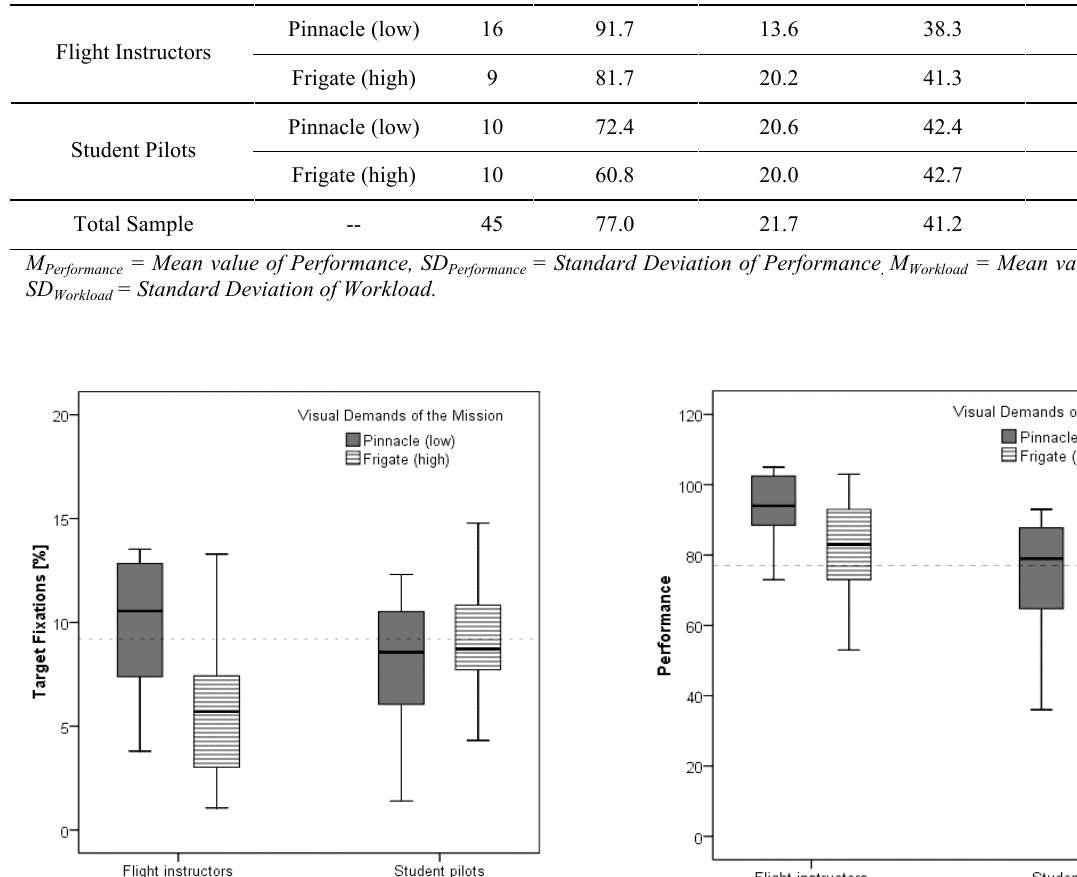
Descriptive Performance and Workload Characteristics Experience